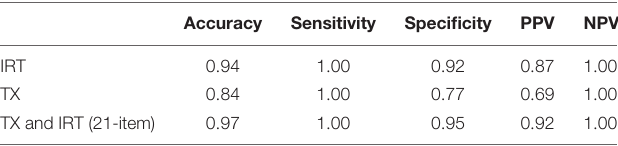
TABLE 3 | Performance metrics compared among IRT, TX, and a combination of TX and IRT (21-item).